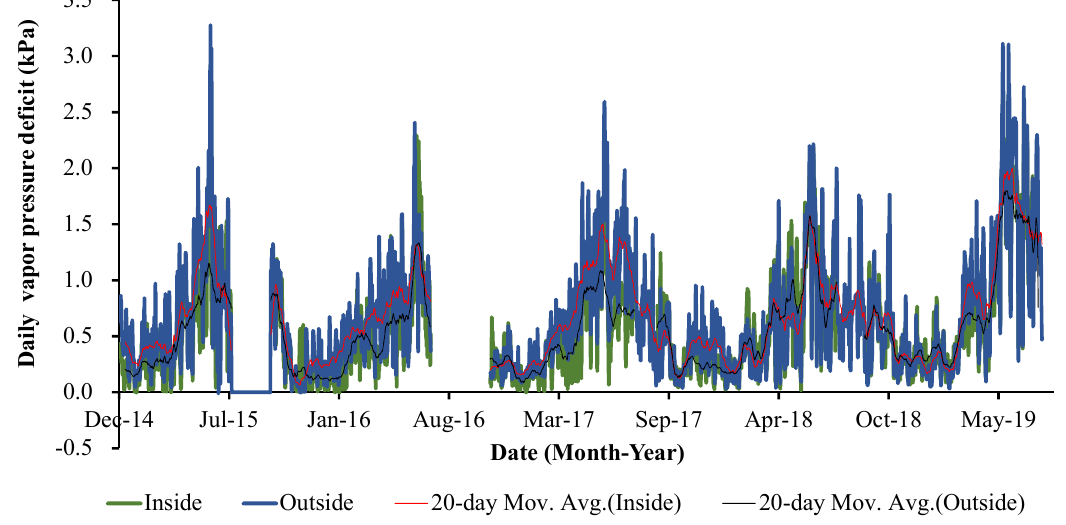
Figure 6. The variation of inside and outside daily vapor pressure deficit (VPD) during the seven seasons. Thin solid lines represent the 20-day moving average of corresponding variables.